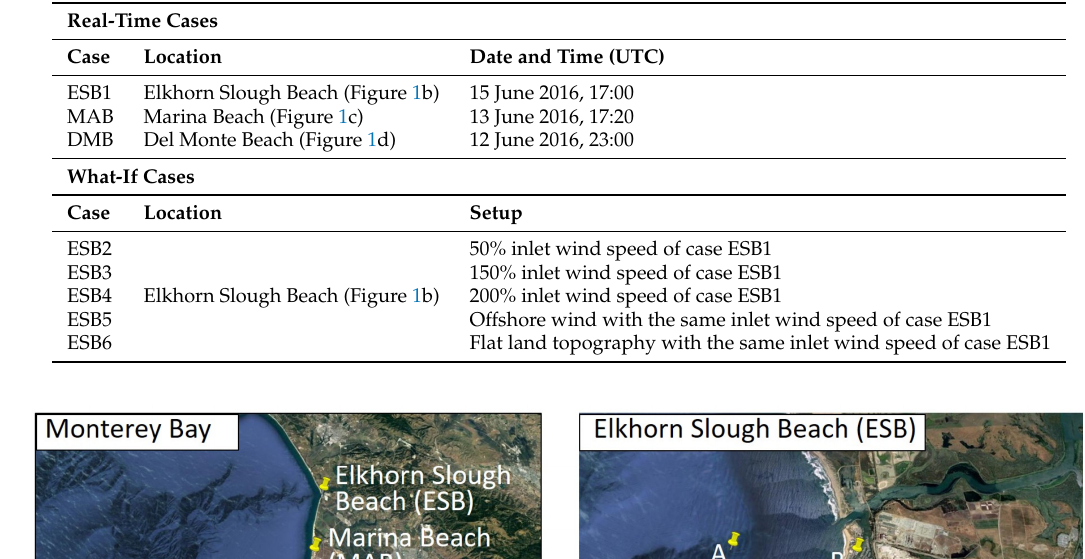
Table 1. Summary of the location, date, and time of large-eddy simulations (LES) cases.